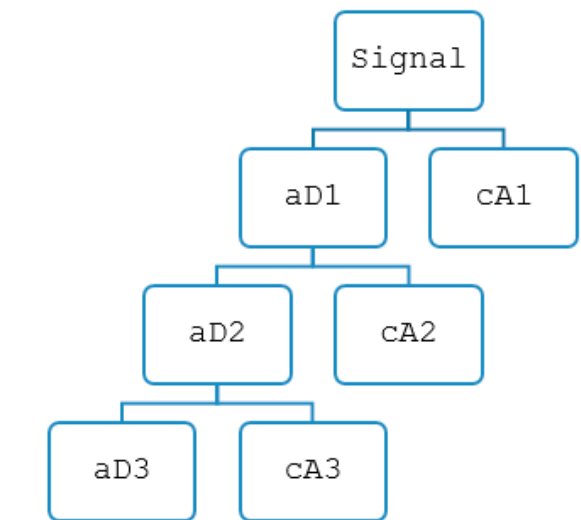
Figure 10. Wavelet decompositions tree. Energies 2020 , 13 , x FOR PEER REVIEW